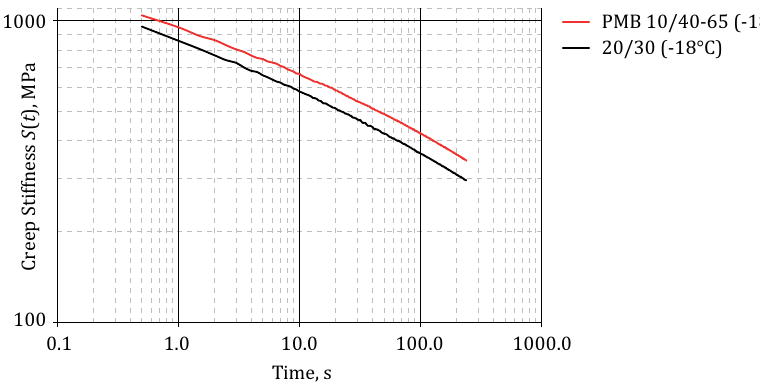
Figure 2. Curves of the creep stiffness modulus versus time for hard consistency